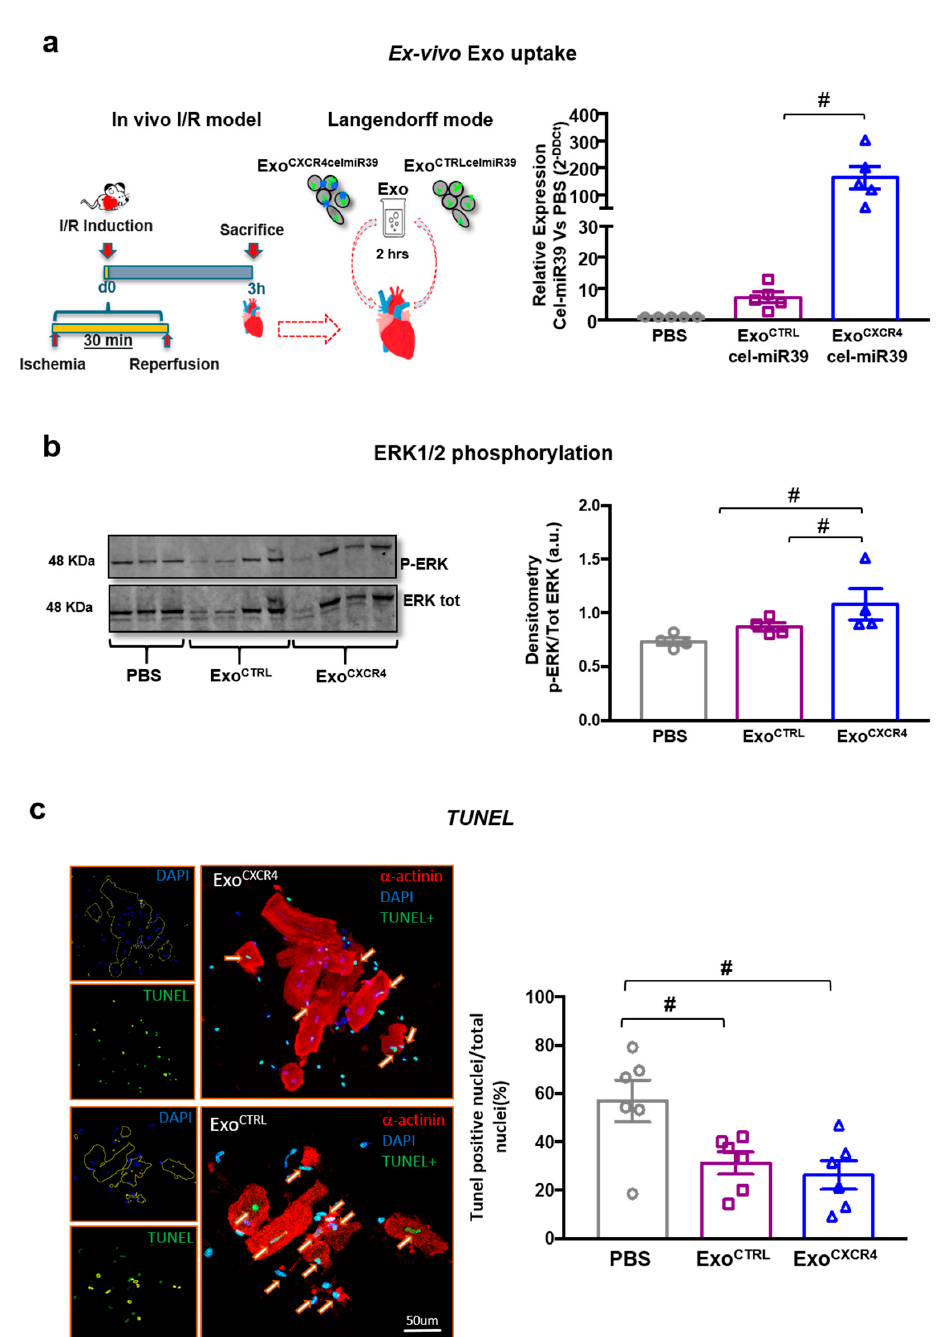
Figure 5. Cellular uptake of Exo by rat adult CM. ( a ) Experimental design. I/R model was induced in rat and 3 h later hearts were excided and retrogradely perfused in a langendorff system for a subsequent 2 h. Exo CTRLcel-miR39 and Exo CXCR4cel-miR39 were added to the perfusates. PBS was added to the control perfusing solution. ( a ) Exo CXCR4cel-miR39 containing perfusates showed increased cel-miR39